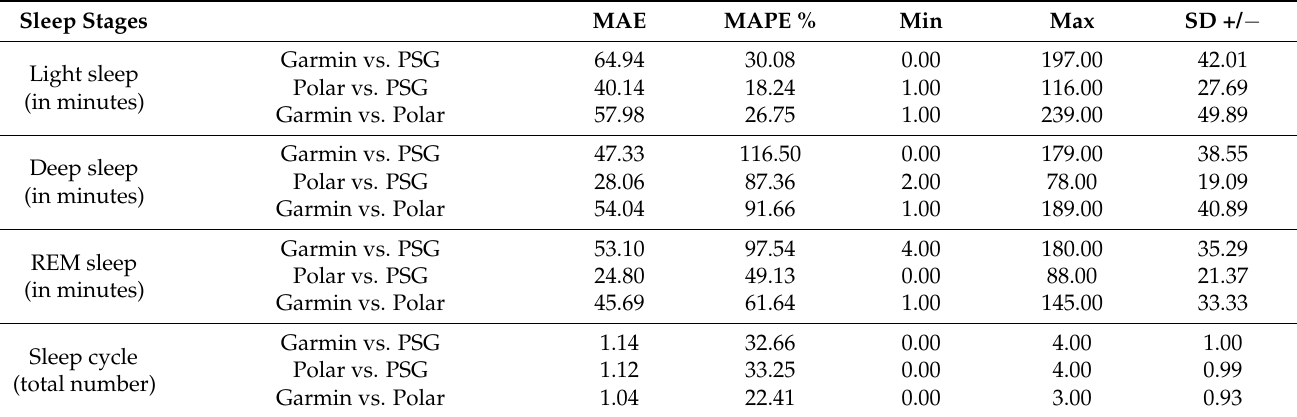
Table 5. Sleep stage deviation calculation of mean absolute error (MAE) and mean absolute percentage error (MAPE) ( n = 49).